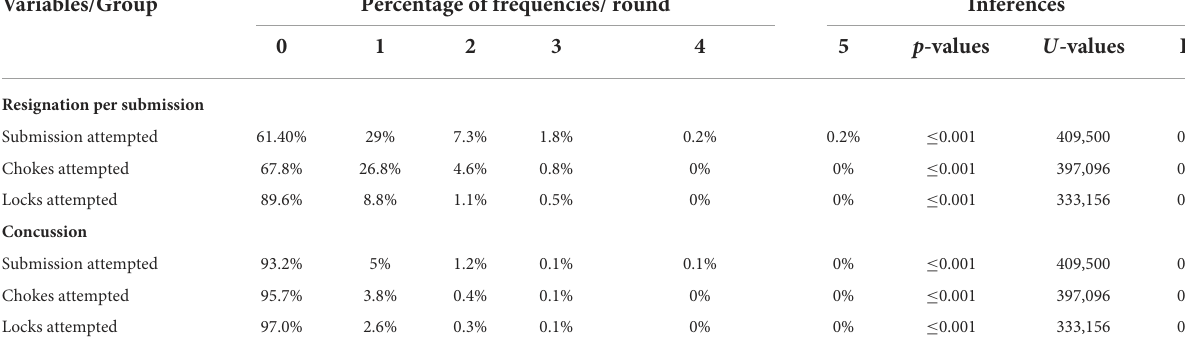
TABLE 3 Submission actions compared by concussion and resignation per submission groups. Variables/Group Percentage of frequencies/ round